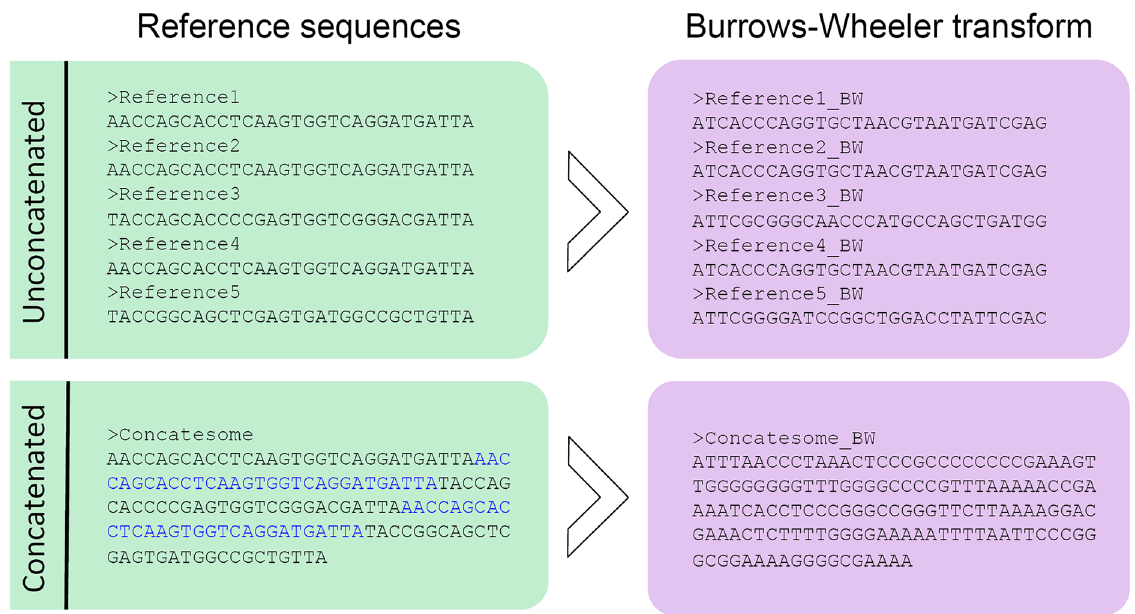
Fig 5. Burrows-Wheeler transform on concatenated sequences. Example of the Burrows-Wheeler transform on both small sequences (top) and a concatenated longer sequence (bottom). The concatenated sequence is more easily searchable using the LF walk. NINJA forms a BWT-compatible concatesome that can be used interchangeably among various BWT-based aligners as an artificial reference chromosome. This concatenated sequence serves as a reference against which environmentally-obtained marker sequences are aligned.